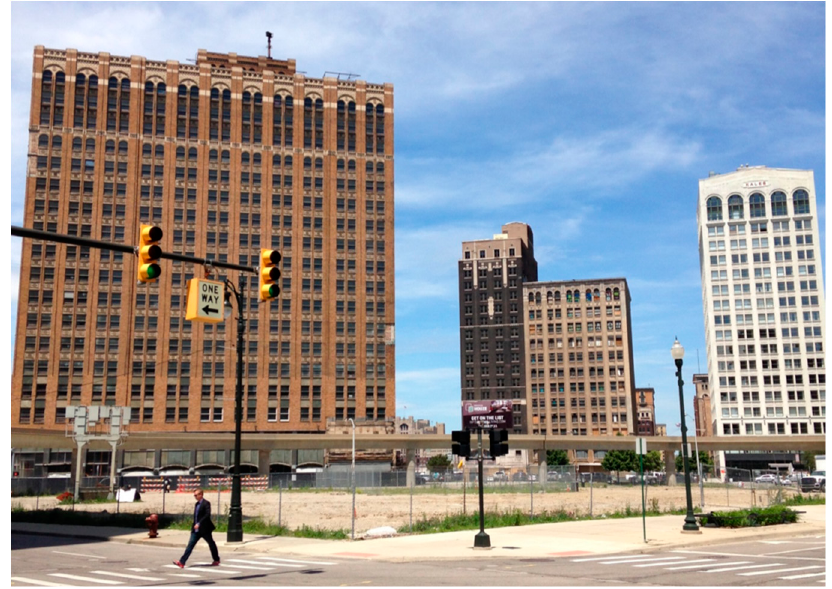
Figure 1. Vacant historic buildings and properties in central Detroit. Source: photo by authors (9 June 2016).